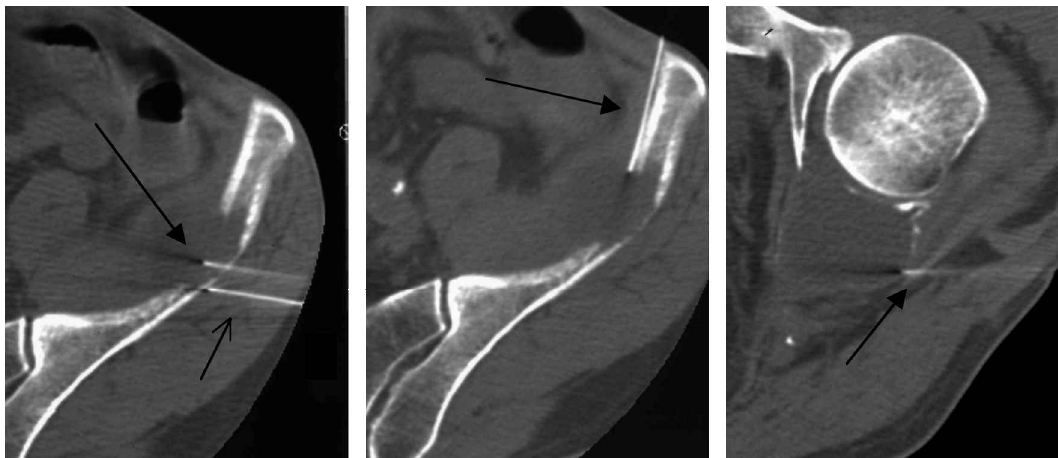
Fig. 2. Plasmocytoma of the left pelvis. CT guided biopsy of three different parts of the tumour. Centrally (a), ventrally (b) and caudally (c). Biopsy needle ( ) and guiding needle (